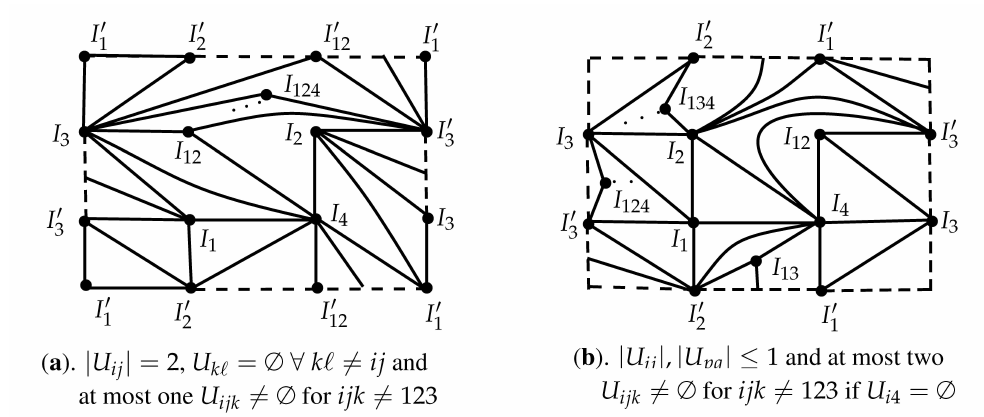
∪ 4 Figure 11. | U n | = 7 with | U 1 | = 2. n = 1 ∪ 4 Case 4 Let | U n | = n = 1